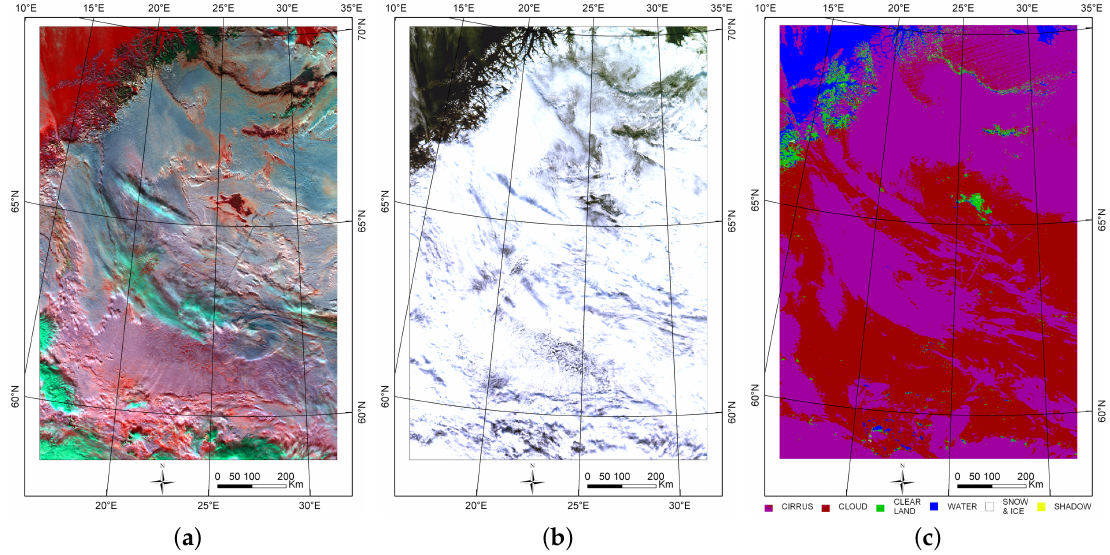
Figure 4. A Suomi NPP VIIRS image of 20 October 2014, at 10:39 a.m. ( a ) SWIR colour composite, RGB composite from 3.7 µ m, 2.2 µ m and 1.6 µ m reflectance; ( b ) Natural colours, Natural colour image from 0.672 µ m, 0.555 µ m and 0.490 µ m reflectance; ( c ) Cloud/shadow result, Cloud and shadow detection